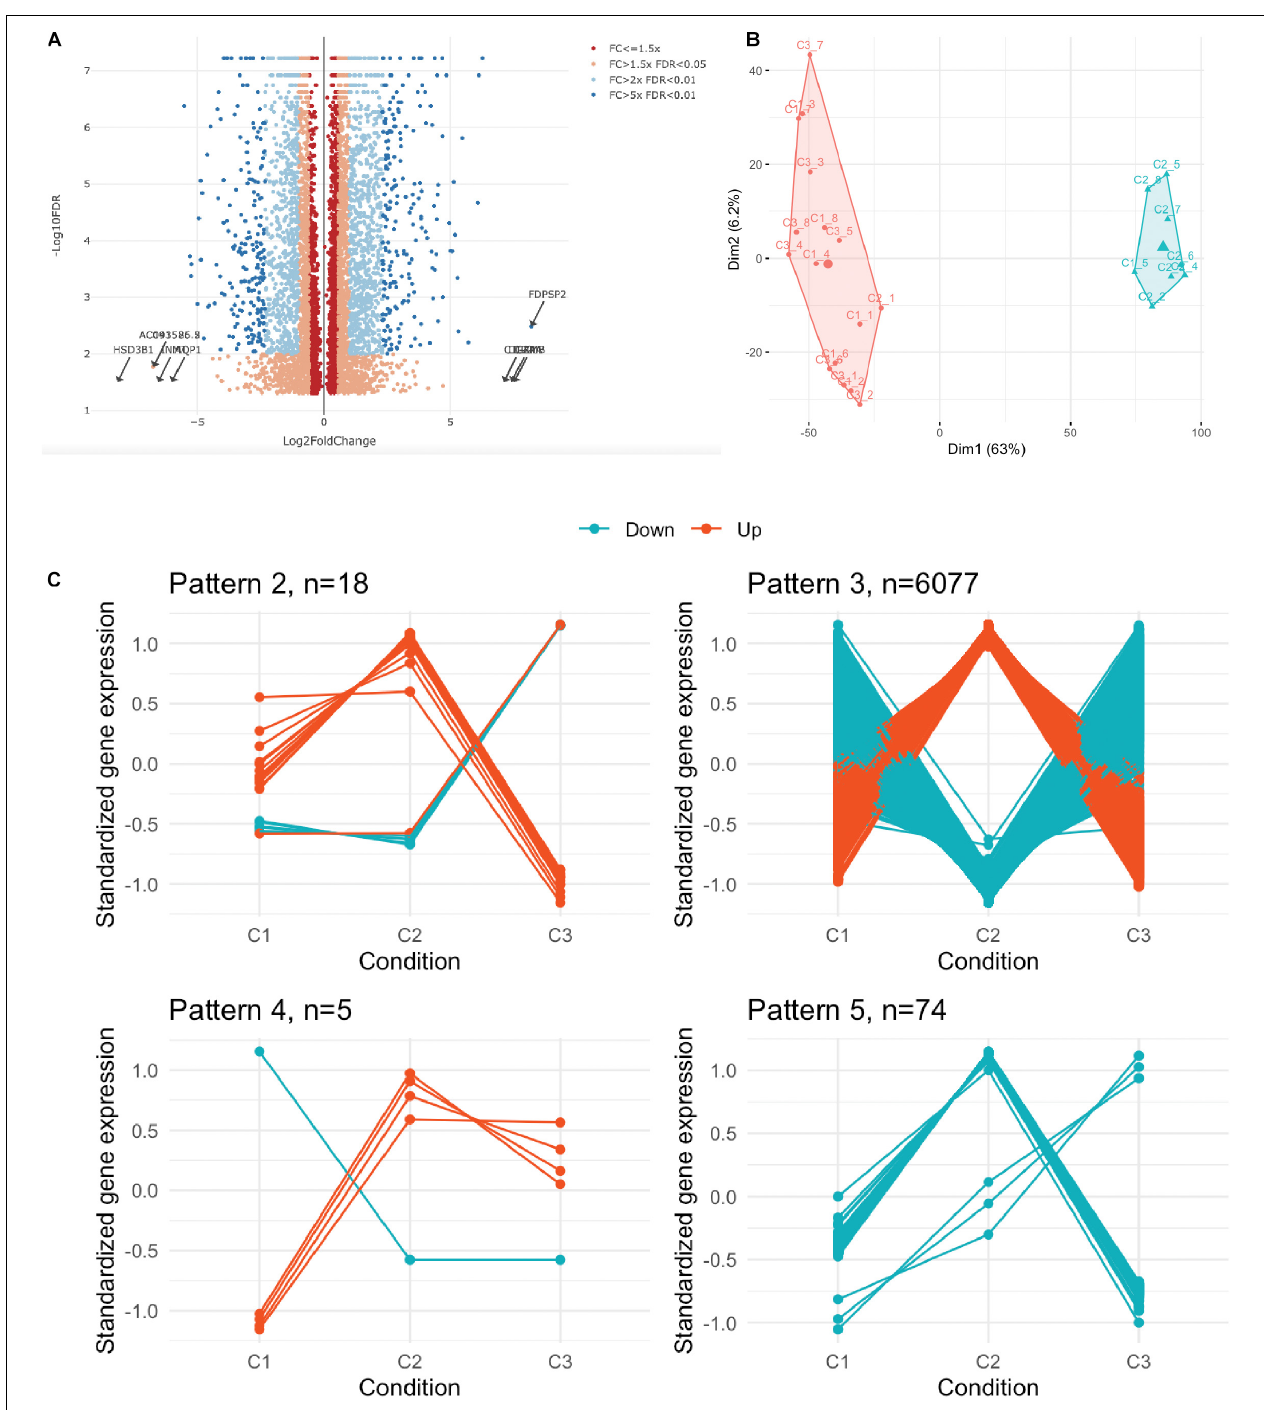
FIGURE 3 | Transcriptome profiling of UC-MSC under experimental inflammation. (A) Volcano plot showing the distribution of all differentially expressed genes. FC, fold change; FDR, false discovery rate. (B) Hierarchical clustering of the 24 transcriptomes based on the normalized counts of differentially expressed genes. (C) Standardized gene expression of DEG in each condition grouped by its identified expression pattern.